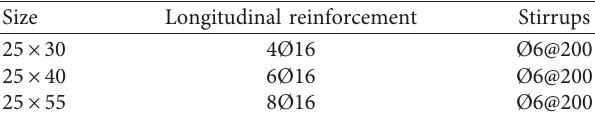
Figure 3: Reference plan of the building that shows the three longitudinal frames ( x direction) and the two transversal frames ( y direction): (a) roof plan; (b) upper floors plan; (c) ground floor plan. Table 2: Characteristics of the column sections at the ground